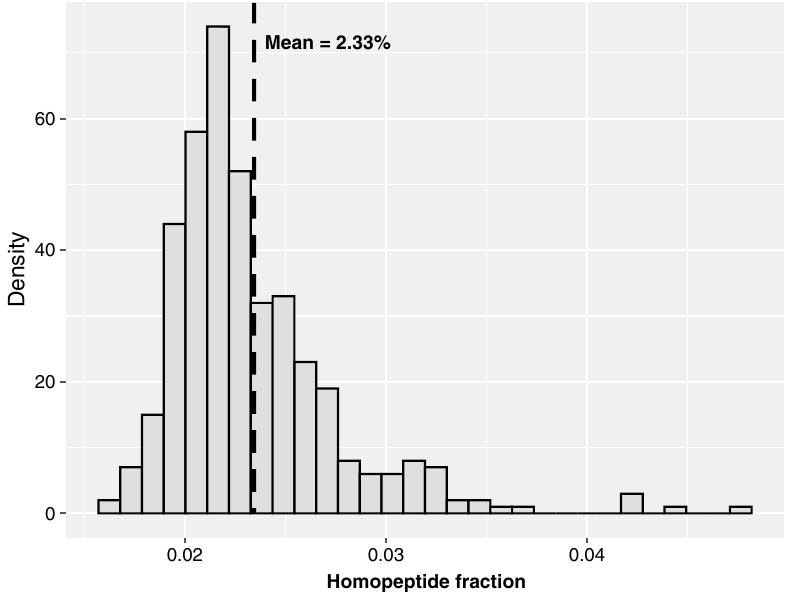
Figure 1. Distribution of overall homopeptide fraction in the proteomes. Mean = 0.023, standard deviation = 0.004, skewness = 2.004, kurtosis = 9.350. Each bin is 0.01 long and labelled with its lower bound.